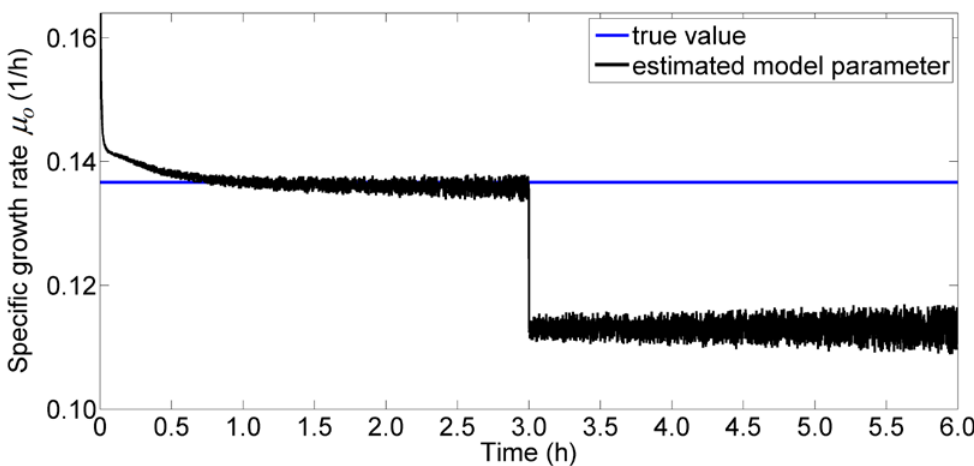
Figure 8. Residual of the estimated model parameter